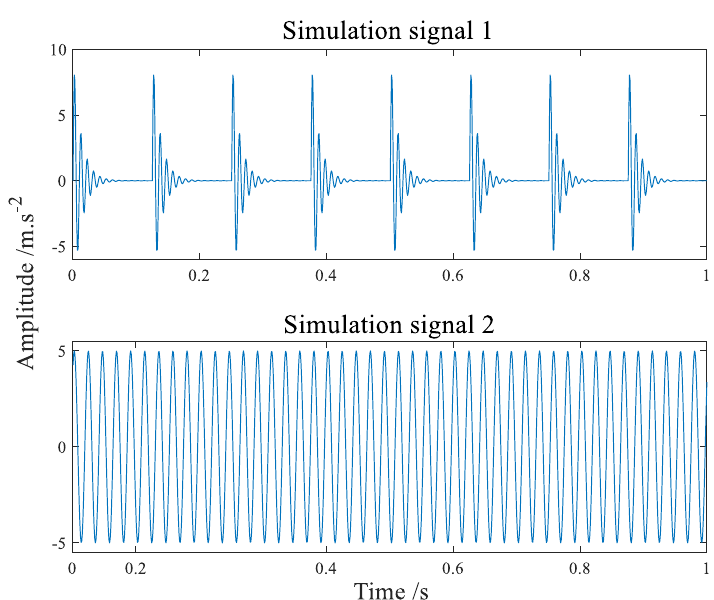
Figure 4. The tim e− domain waveform of simulation signals. Figure 4. The time − domain waveform of simulation signals.